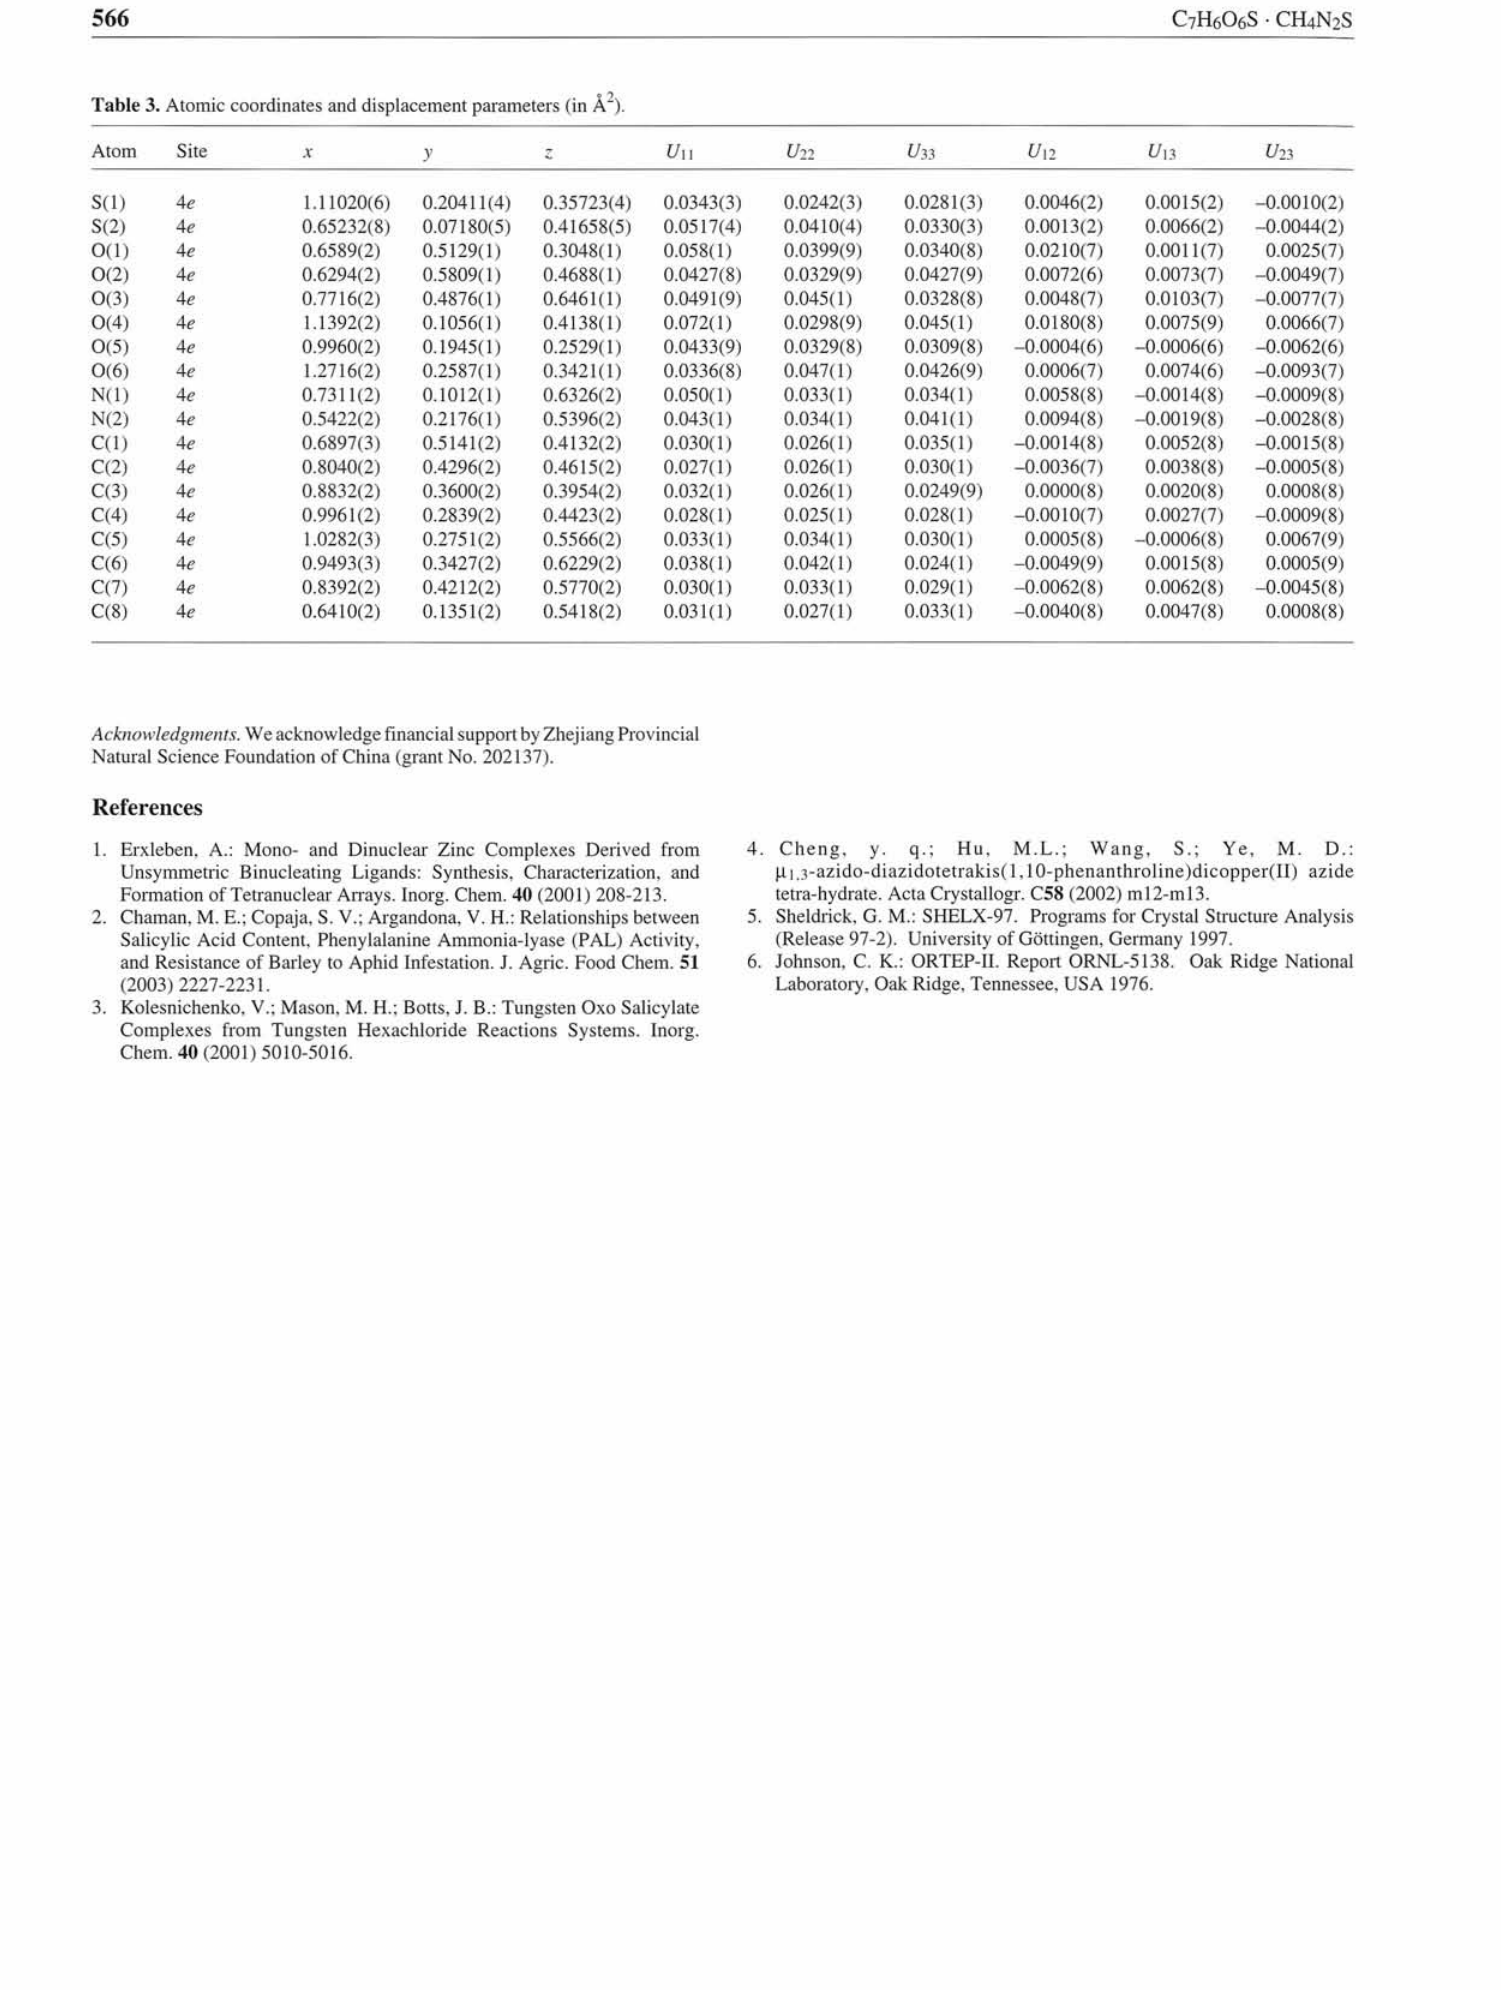
Table 3. Atomic coordinates and displacement parameters (in Á 2